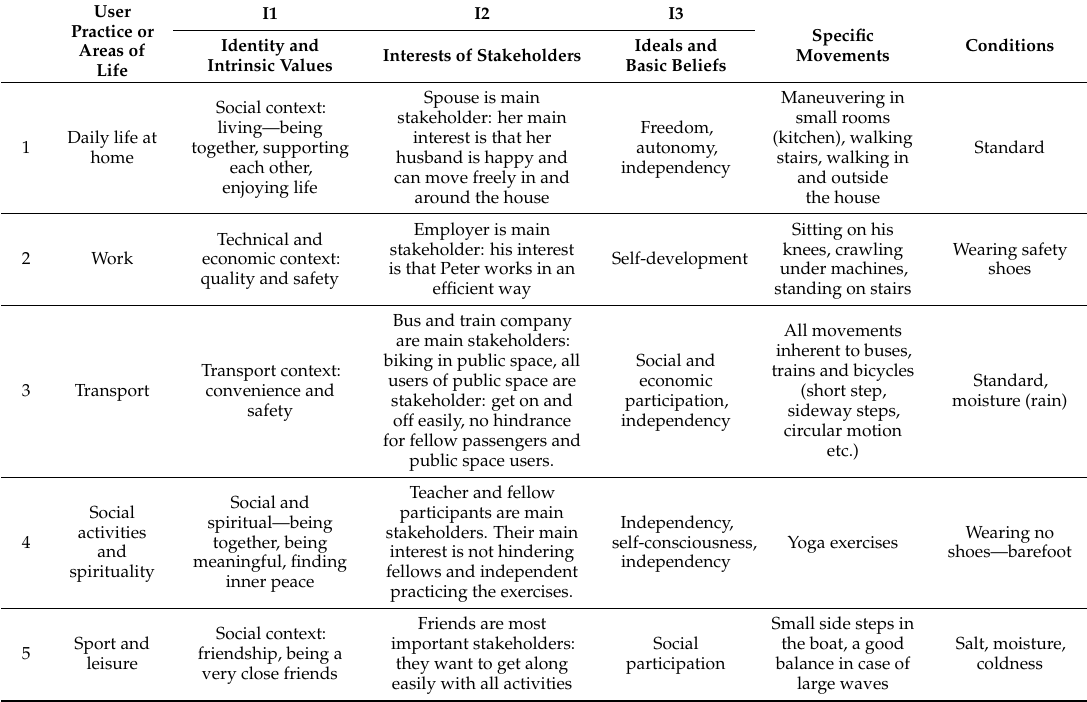
Table 1. A summary of all details of the life of Peter that are relevant for prescribing an ankle foot orthosis.